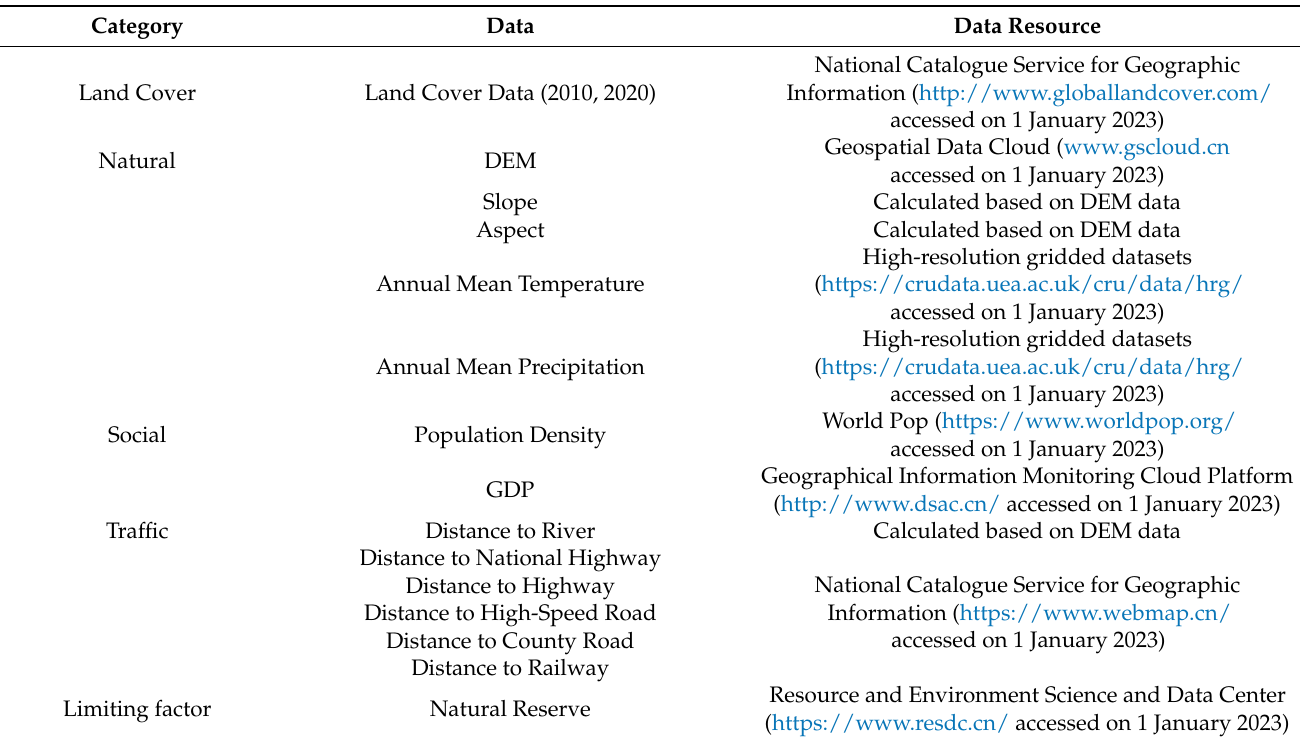
Table 1. The spatial driving factors of the land cover change in this